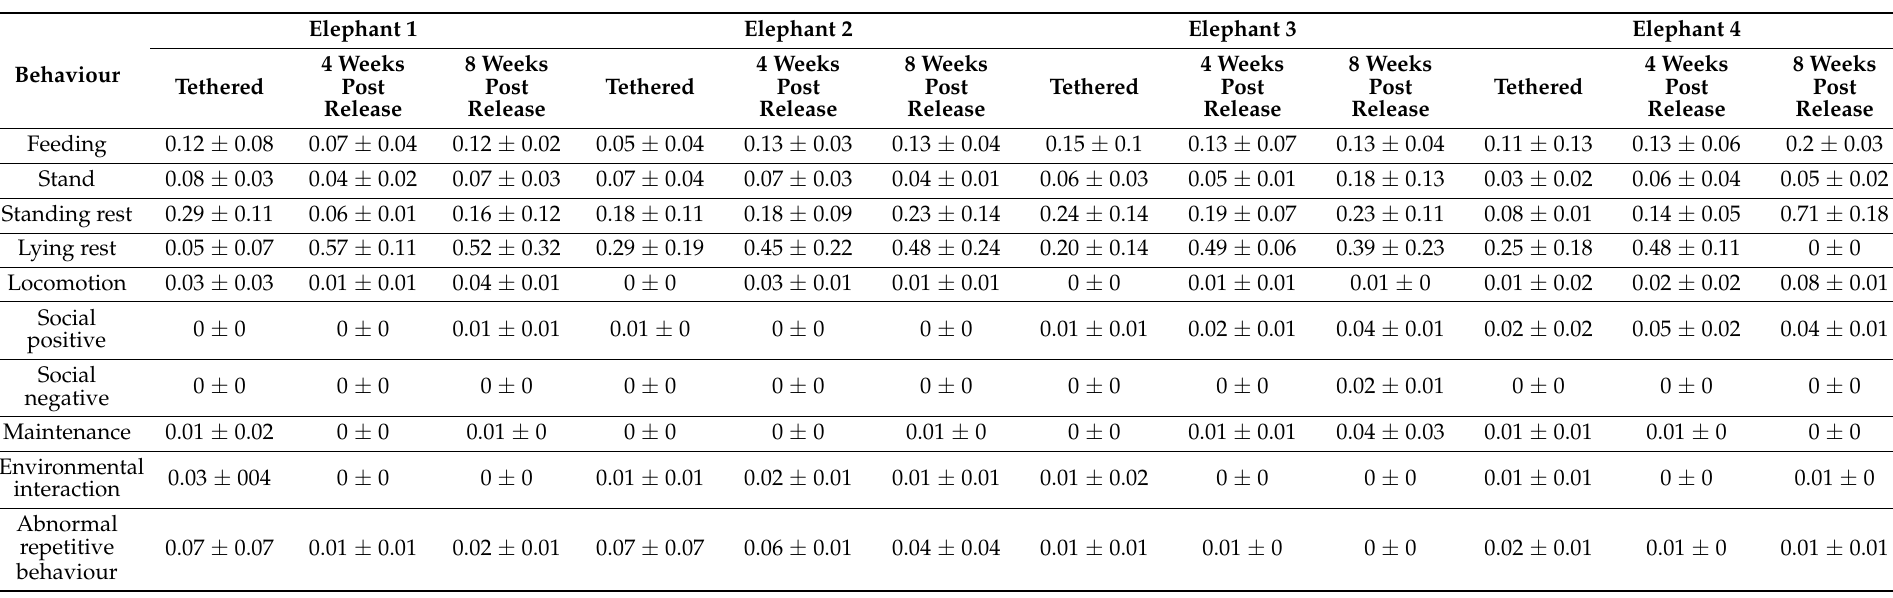
Table 3. An overview of changes in mean proportion of time per observation night spent engaging in behaviour across the three conditions, reported as mean ±